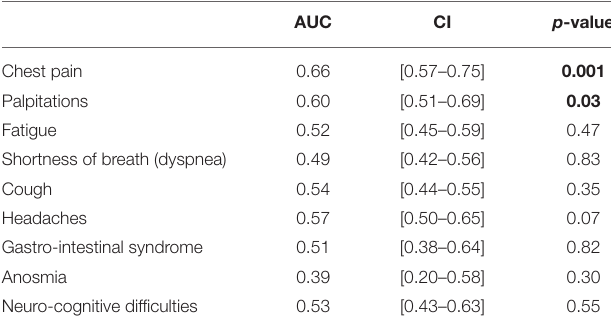
TABLE 3 | Correlation between endothelial function improvement and long-COVID-19 symptoms